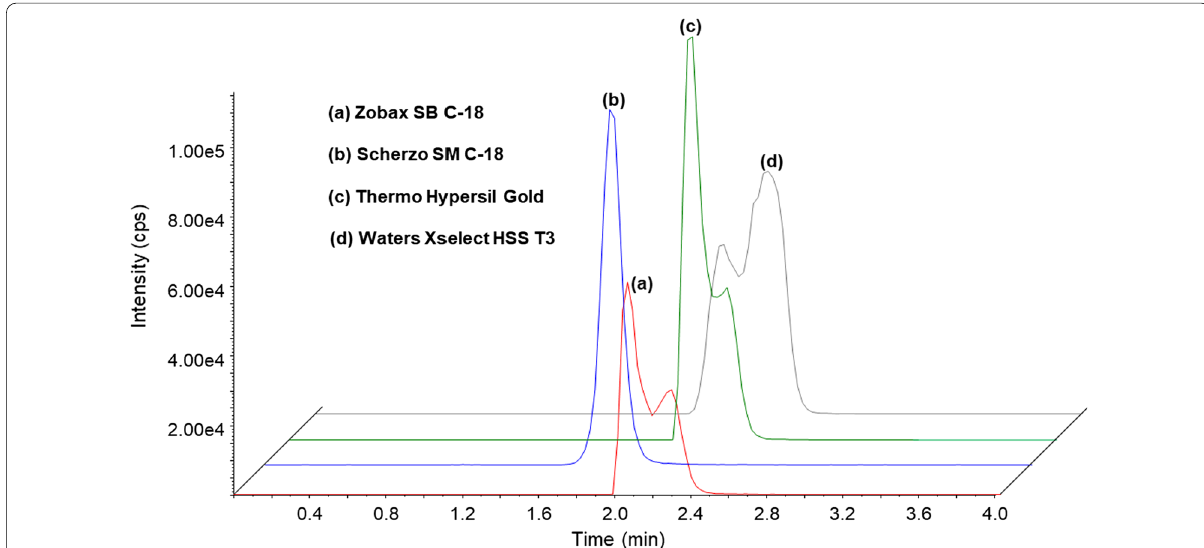
100 mm, 3 µm), c Thermo ×